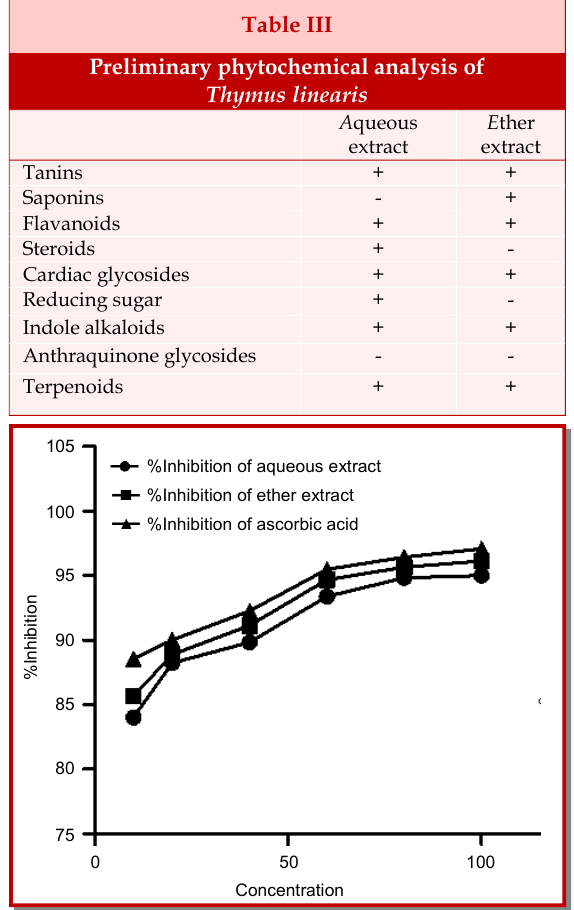
Figure 1: Percent inhibition of ascorbic acid, aqueous and ether extract of Thymus